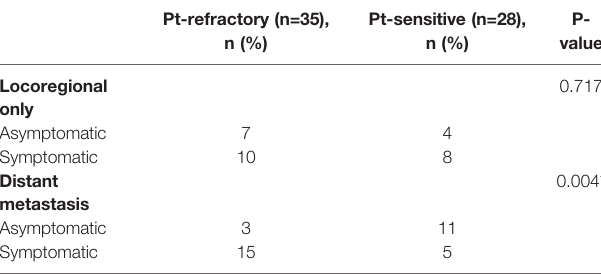
TABLE 4 | Characteristics of the platinum-refractory and -sensitive recurrence at the detection of recurrence. Pt-refractory (n=35), n (%)